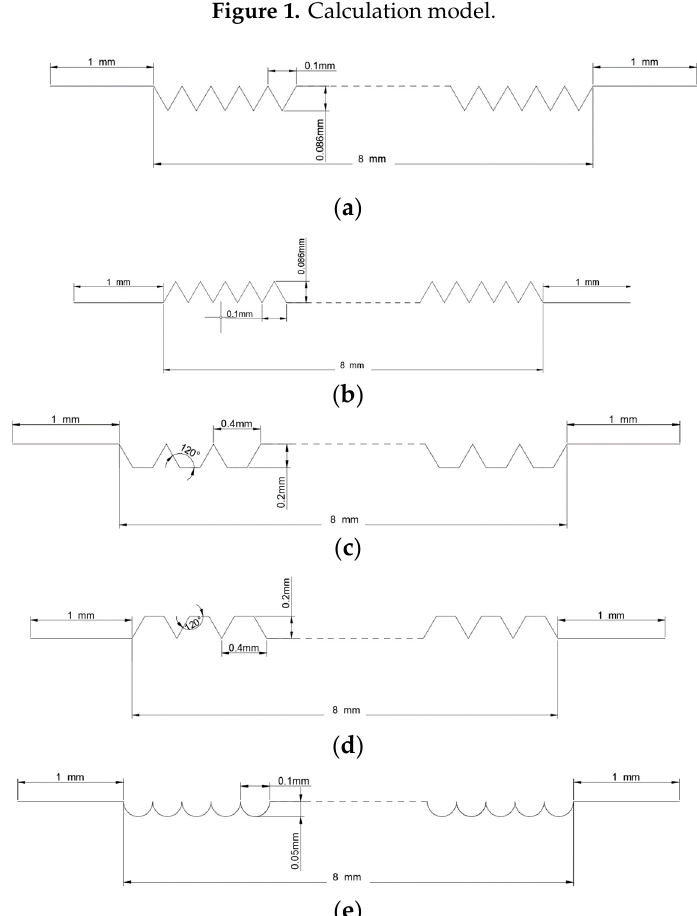
Figure 2. Different riblets and grooves plate model (not to scale). ( a ) Triangular concave grooves, ( b ) triangular protrusion riblets, ( c ) trapezoidal concave grooves, ( d ) trapezoidal protrusion riblets, and ( e ) circular concave grooves.